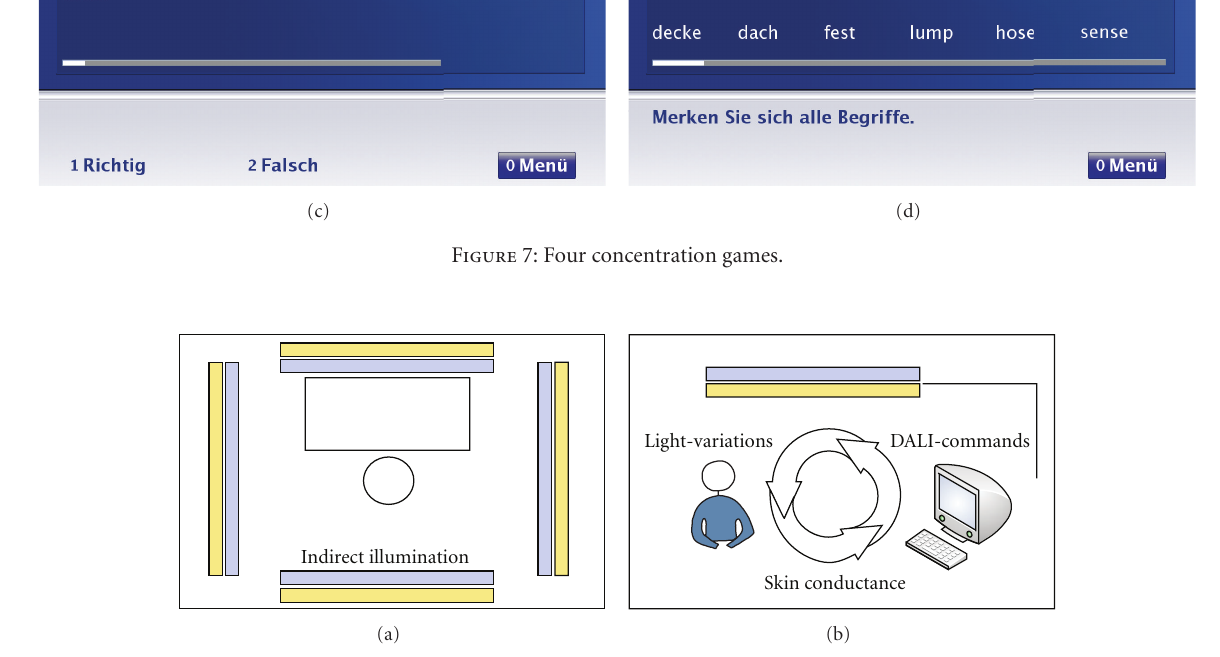
Figure 8: Lighting setup and feedback loop for the evolutionary light